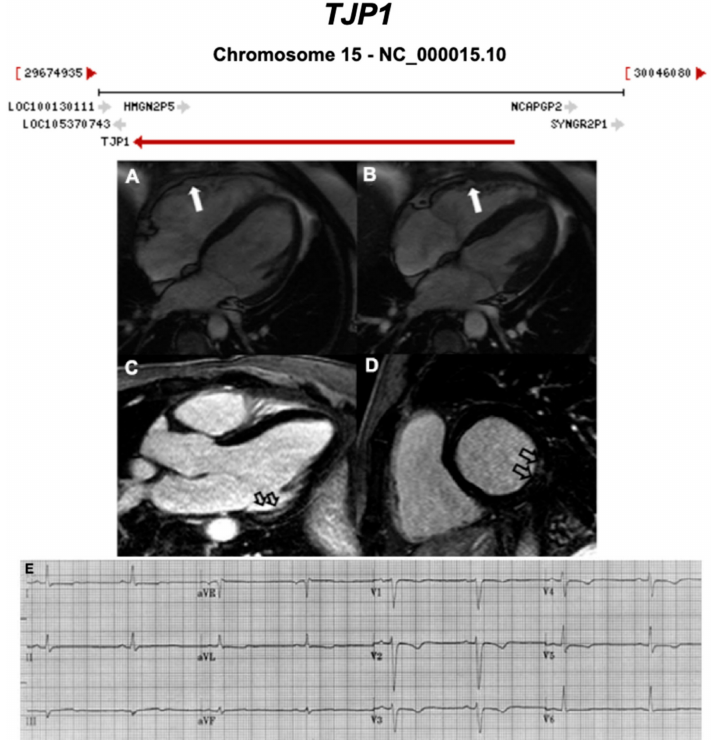
Figure 13. Exemplar MRI and ECG finding found in ACM patients with TJP1 mutations. ( A , B ) CMR of a patient with TJP1 p.Tyr669Cys mutation showing right ventricular dilatation (white arrows); ( C , D ) LGE shows mid-mural fibrosis in the inferior-lateral wall of the left ventricle (empty arrows); ( E ) 12-lead ECG of the same patient showing shows sinus rhythm, intra-ventricular conduction delay, and T wave inversion in V1 to V5. Reproduced with permission from De Bortoli et al. (2018)